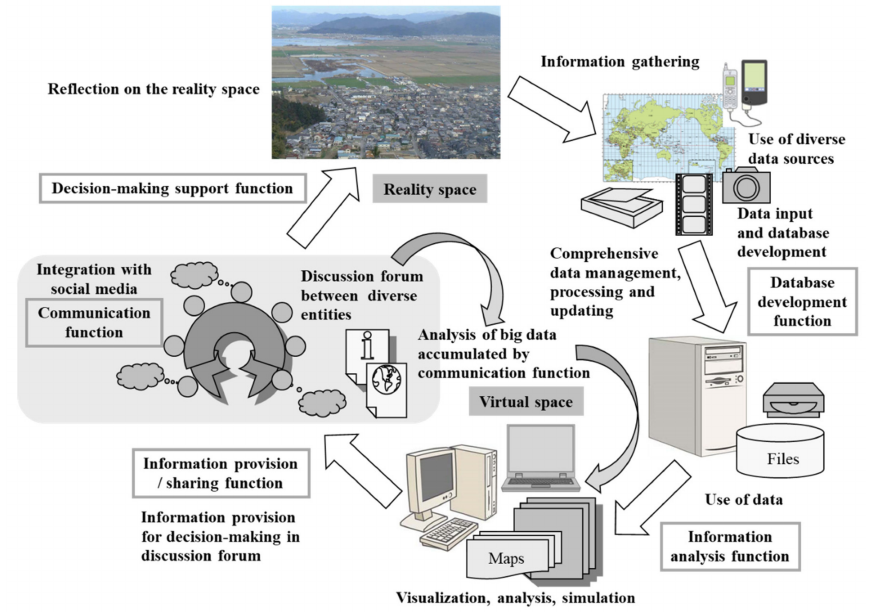
Figure 2. The various functions of Geographic Information Systems (GIS) and their involvement in